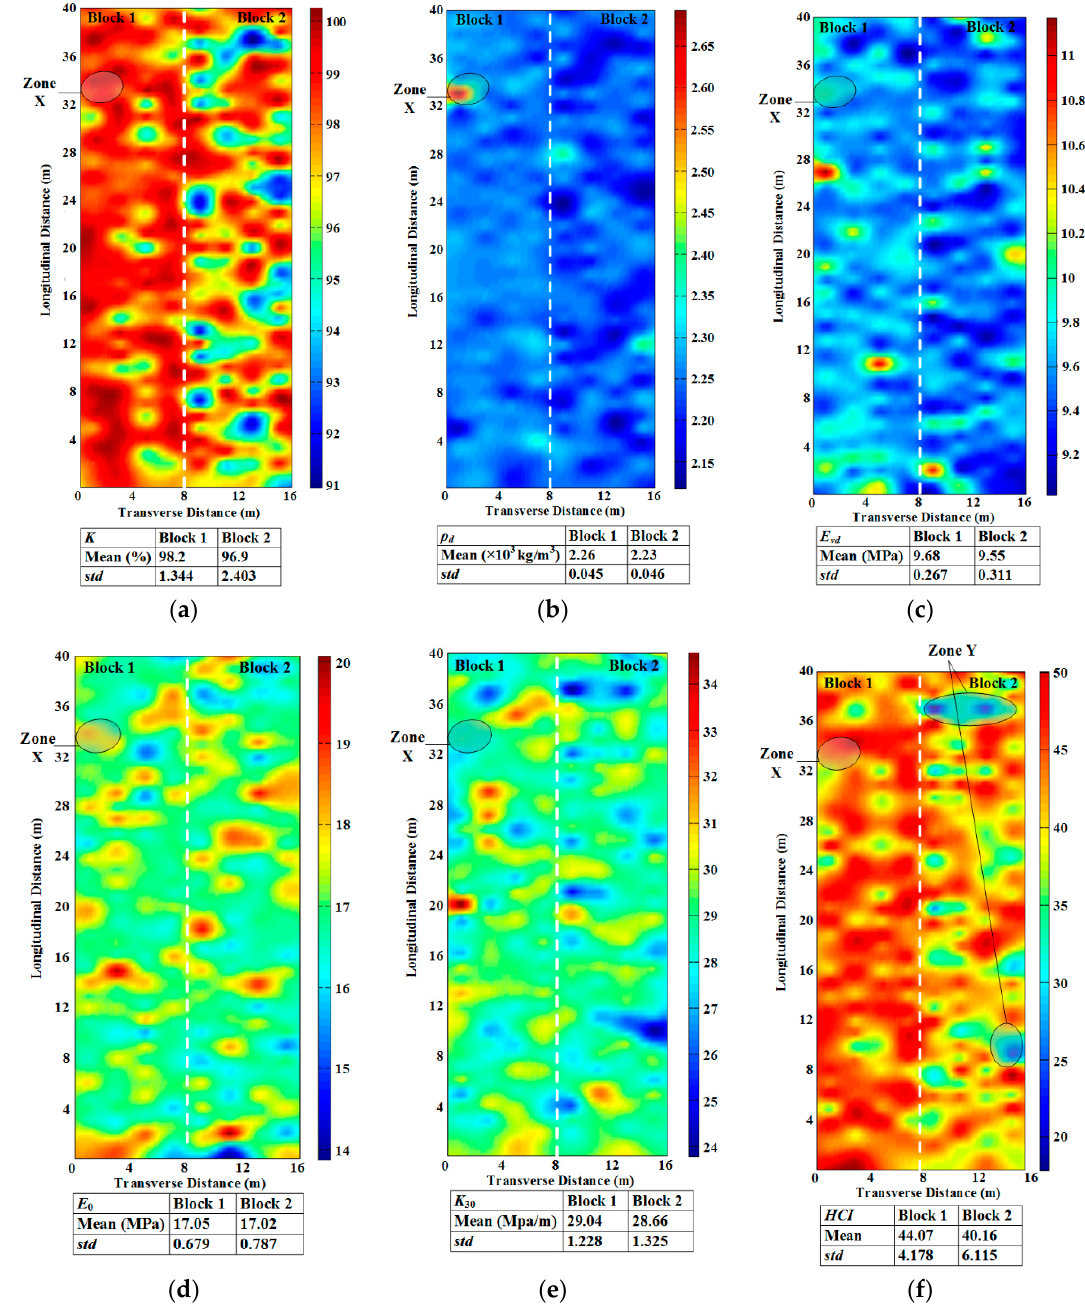
Figure 8. Contour maps of evaluation indices of each block: ( a – e ) the physical and mechanical indices; ( f ) the hybrid index HCI.